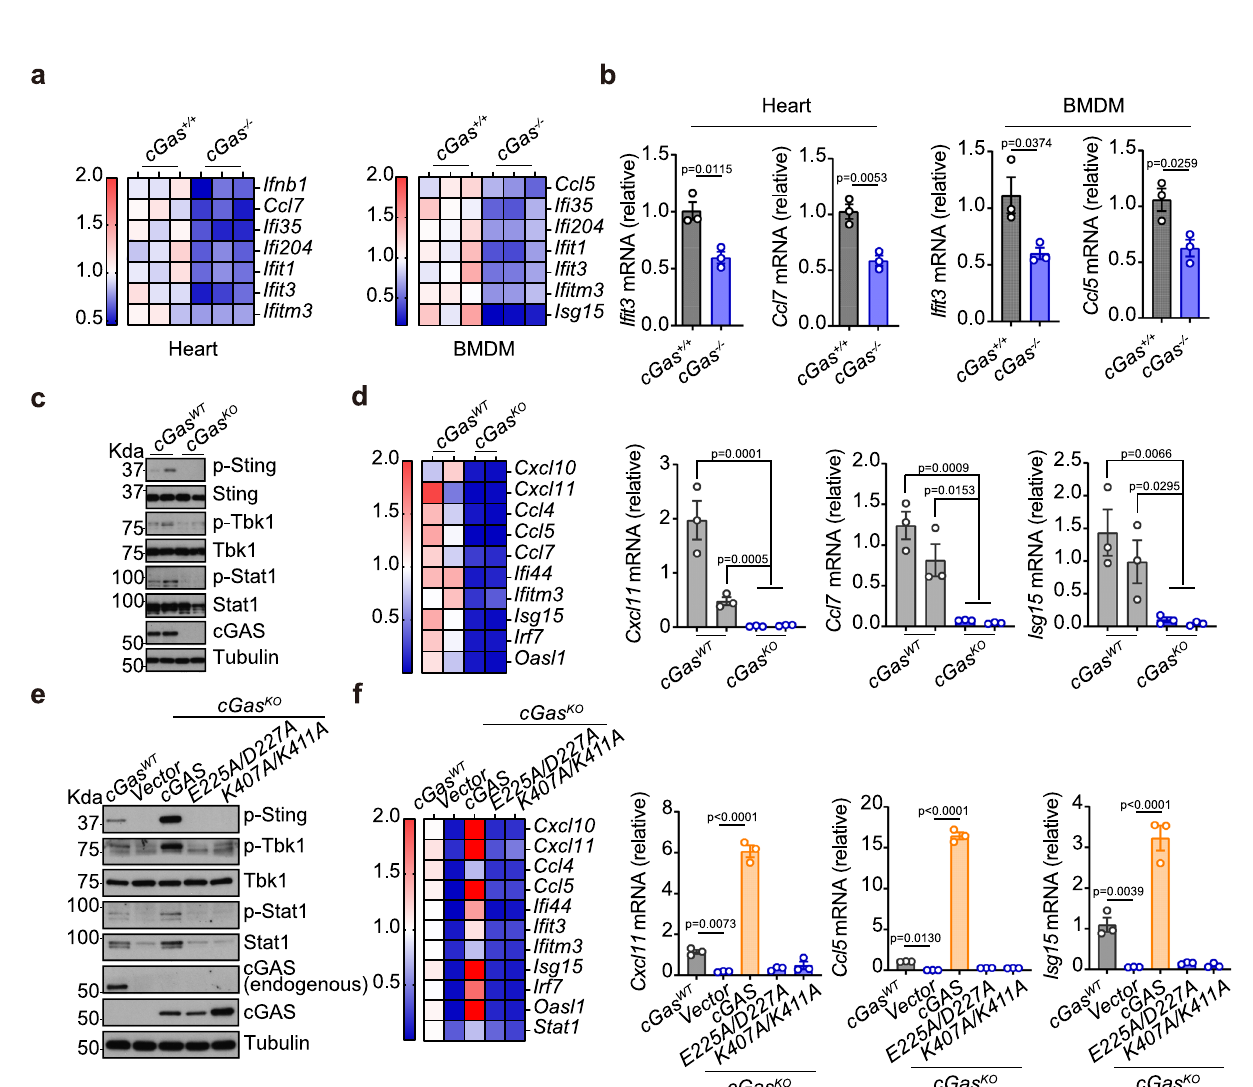
Fig. 4 | Both cGAS and STING are required for tonic IFN signaling in Gcc2-KO cells.a , b WesternBlot( a )andqRT-PCR( b )analysisoftonicIFNsignalingin Gcc2 WT , Gcc2 KO , Gcc2 KO STING KO , and Gcc2 KO cGAS KO MEFs. Two independent CRISPR/Cas9 knockoutclonesofeachgenotypeareincluded.p-Sting,p-Tbk1,andp-Stat1arekey phosphorylation events of the STING signaling pathway ( a ). Expression of IFN genes and ISGs are shown in a heatmap ( b , left) and representative bar graphs ( b ,right). n =3. c , d WesternBlot( c )andqRT-PCR( d )analysisoftonicIFNsignaling in Gcc2 WT , Gcc2 KO , Gcc2 KO cGAS KO MEFs reconstituted with vector control, wild-type cGAS, E225A/D227A cGAS (enzymatic-dead mutant), K407A/K411A cGAS (DNA- binding mutant).Cellswere analyzedasin a , b . n =3. e , f Western Blot( e )and qRT-